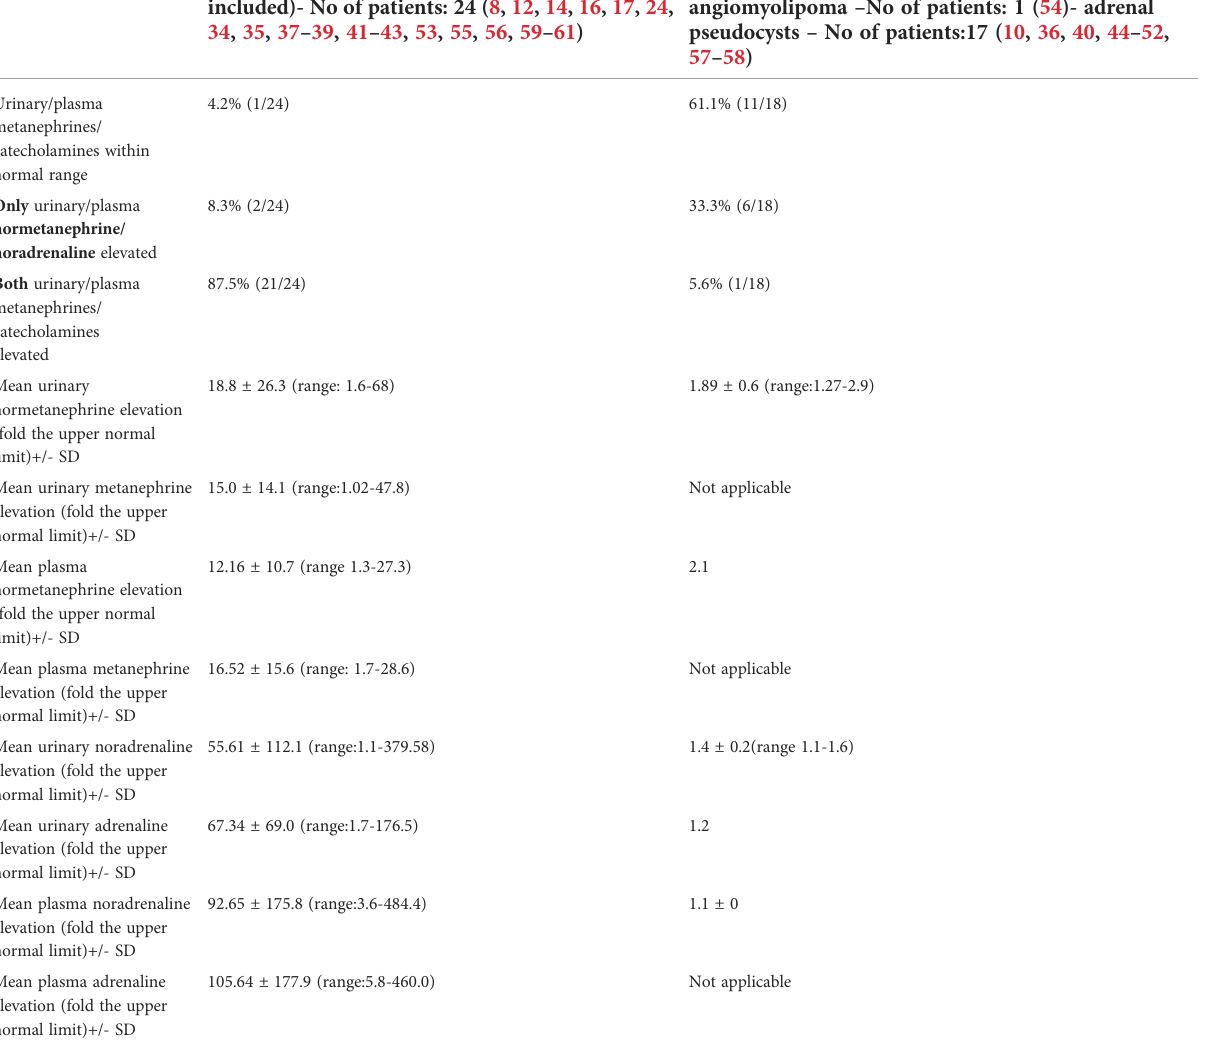
TABLE 3 Levels of catecholamines/metanephrines in patients with hemorrhagic pheochromocytoma and adrenal bleeding without pheochromocytoma based on the literature (8, 10, 12, 14, 16, 17, 24, 34 – 61). Hemorrhagic pheochromocytoma (our cases included)- No of patients: 24 (8, 12, 14, 16, 17, 24, 34, 35, 37 – 39, 41 – 43, 53, 55, 56, 59 –